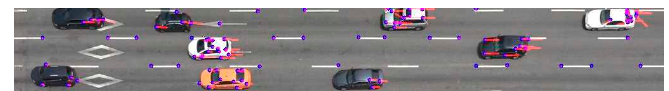
Figure 18. A sample image drawn from the car model provided by Vissim.